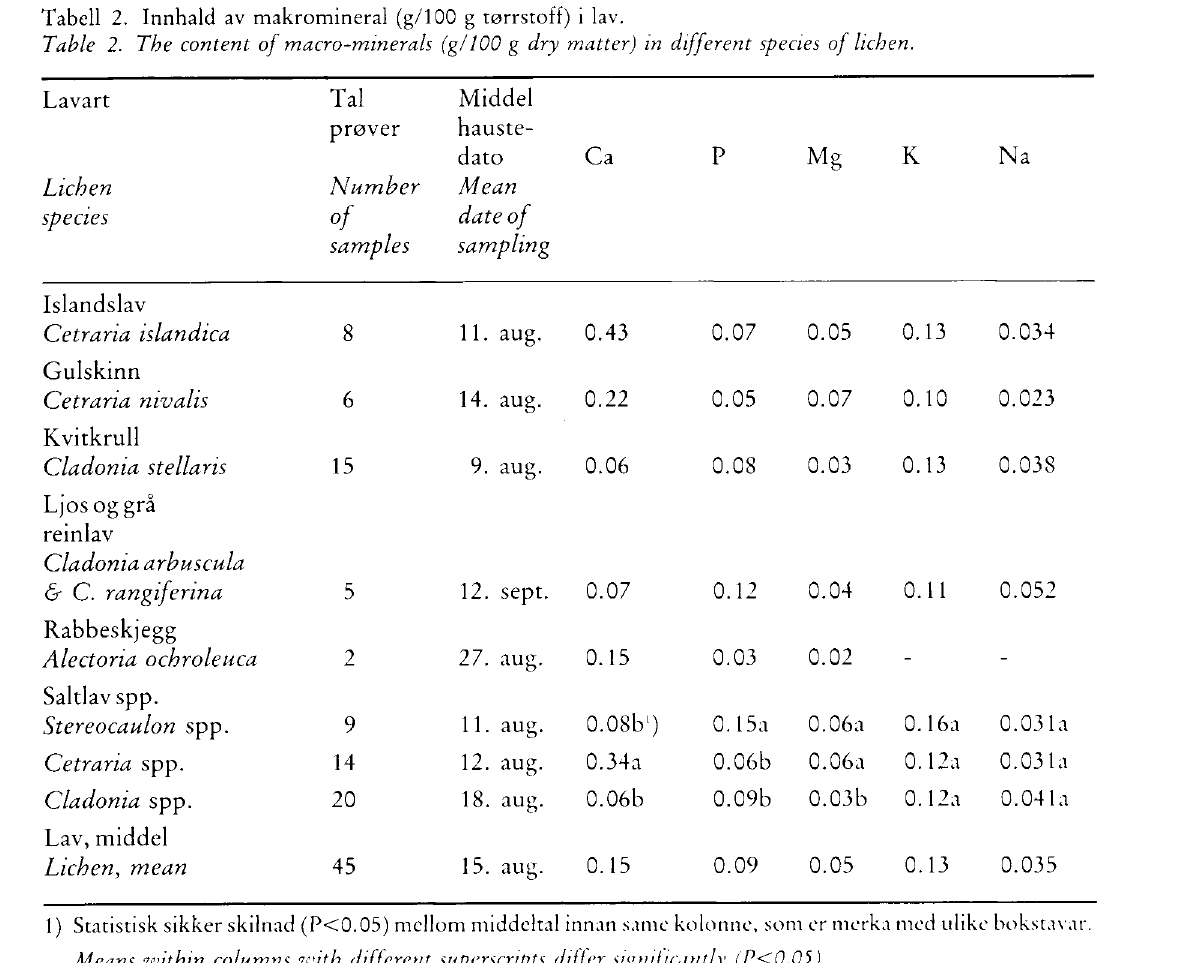
Table 2. The content of macro-minerals (g/100 g dry matter) in different species of lichen.